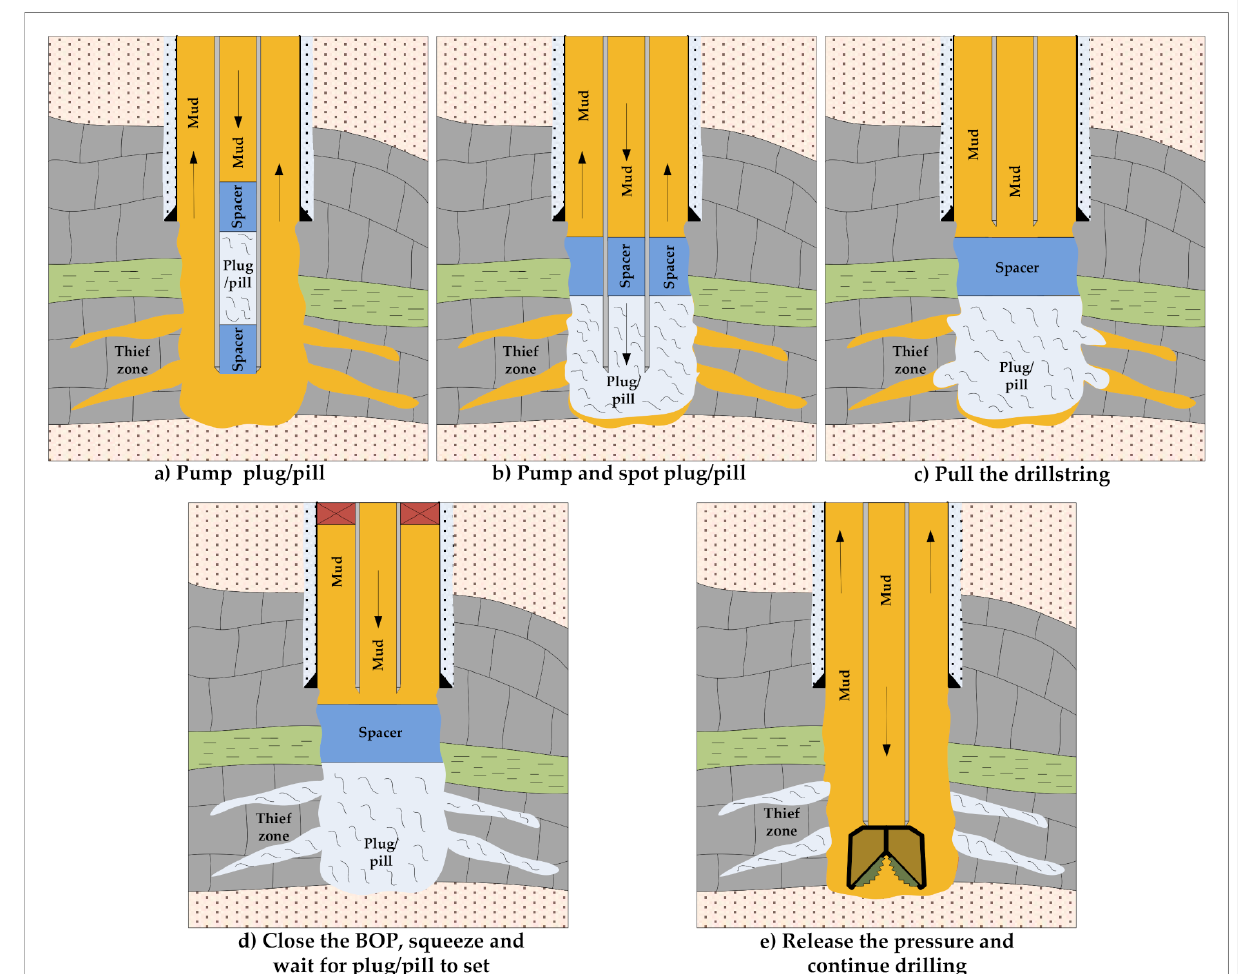
Figure 6. Procedure of spotting and squeezing cement-based plugs or polymer-based